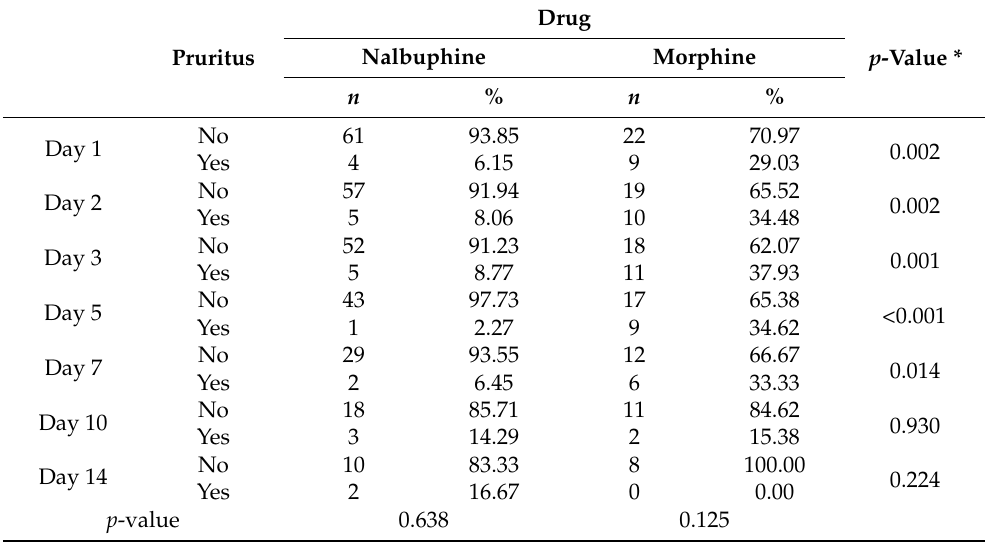
Table 5. Comparison of the incidence of pruritus between patients receiving nalbuphine or morphine.